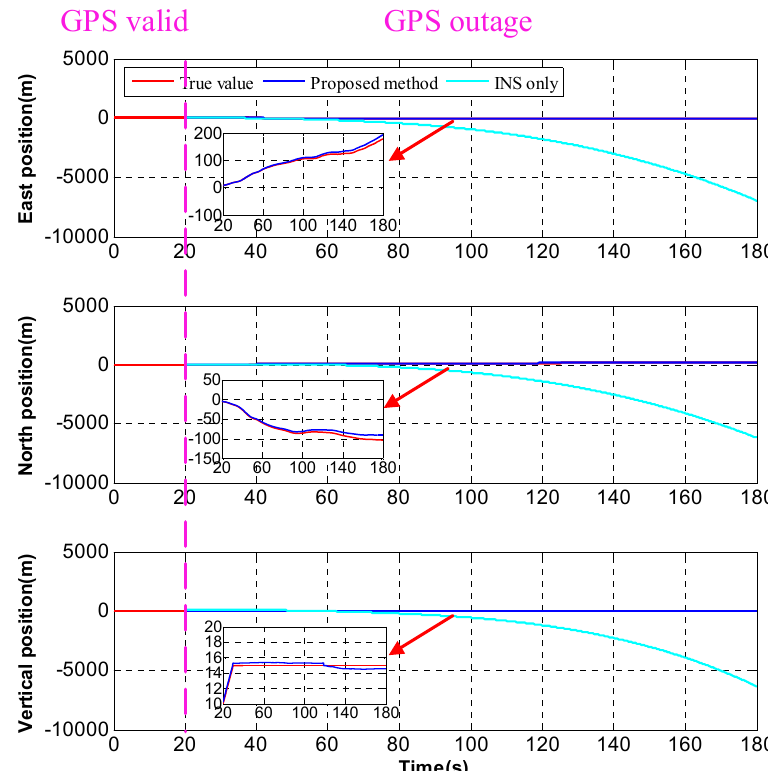
Figure 15. Comparison of position results.